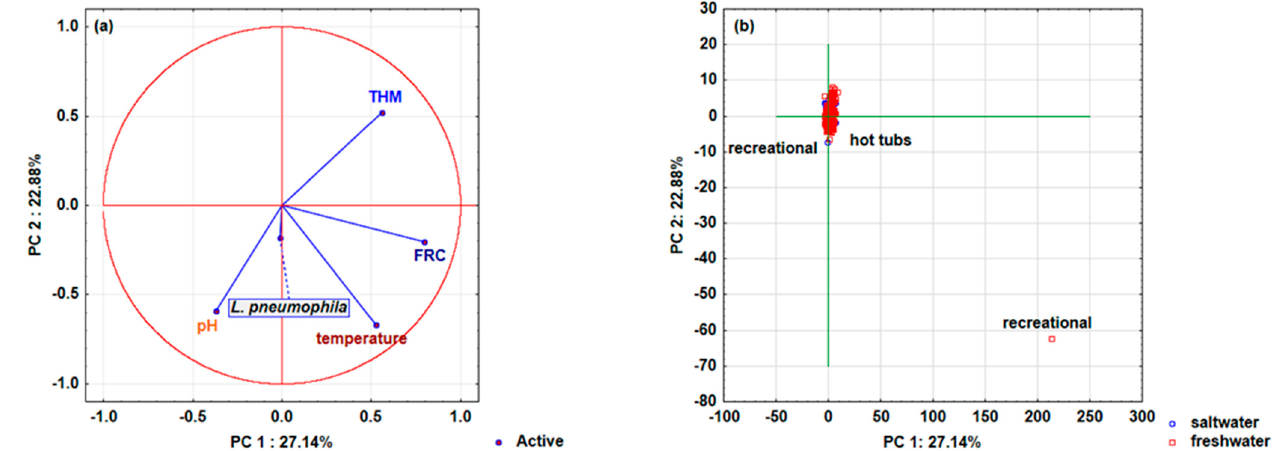
Figure 5. Distribution of analyzed swimming pool water’s chemical parameters (temperature ( ◦ C), pH, trihalomethanes (THM; µ g/L), free residual chlorine (FRC; mg/L)), and bacteria: Legionella pneumophila (CFU/L) depending on water in the swimming pool (saltwater or freshwater) and type of swimming pool (children´s, recreational, hot tub, or sports/Olympic), represented by principal com- ponent analysis (PCA) with main components PC 1 and PC 2. Projections of ( a ) the variables (swim- ming pool water’s chemical parameters and bacteria) and ( b ) cases (type of swimming pools and water in the swimming pools) on the factor plane. (N pool data = 4587; N saltwater data = 1478; N freshwater data = 3109).